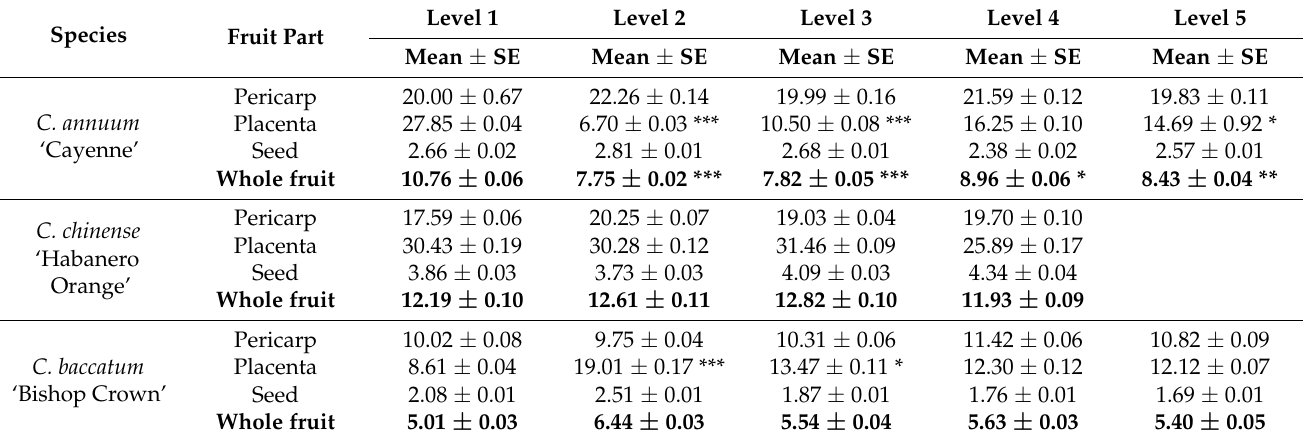
Table 4. Total phenolic content (g GAE/kg DW, mean ± SE) in different species and three fruit parts.